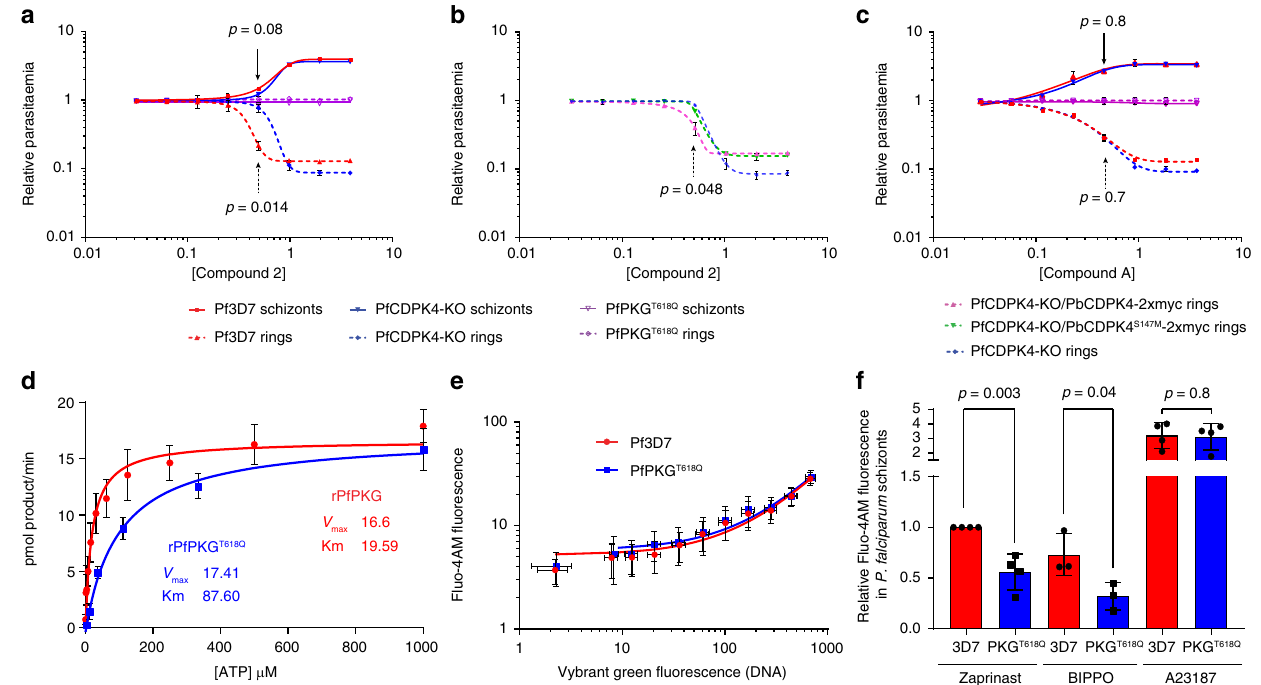
Fig. 2 The CDPK4/PKG functional interaction is conserved to control P. falciparum merozoite invasion. a Difference in ring and schizont parasitaemia after 3 h of C2 treatment added on synchronised segmented schizonts in the control 3D7, PKG T618Q , and CDPK4-KO lines (error bars show standard deviations from the mean; 2 independent cultures; two-tailed t -test). b Difference in ring and schizont parasitaemia after 3 h of C2 treatment added on synchronised segmented schizonts in the CDPK4-KO line and in daughter lines complemented with P. berghei CDPK4 or CDPK4 S147M alleles (error bars show standard deviations from the mean; 2 independent cultures; two-tailed t -test). c Difference in ring and schizont parasitaemia after 3 h of Compound A treatment added on synchronised segmented schizonts in the control 3D7, PKG T618Q , and CDPK4-KO lines (error bars show standard deviations from the mean; 2 independent cultures; two-tailed t -test). d Determination of the ATP Km for recombinant PfPKG and PfPKG T618Q . e Fluorescence of the cell permeable calcium probe Fluo-4-AM in non-synchronised 3D7 and PKG T618Q parasites labelled with the DNA dye Vybrant Green (error bars show standard deviations from the mean; 2 biological replicates). f Relative fl uorescence response of Pf3D7 and PfPKG T618Q lines loaded with the calcium indicator Fluo- 4-AM in response to the phosphodiesterase inhibitors Zaprinast and BIPPO as well as the ionophore A23187 (error bars show standard deviations from the mean; 3 or 4 biological replicates, two-tailed t PfPKG T618Q line, this has no effect on baseline Ca 2 + levels in